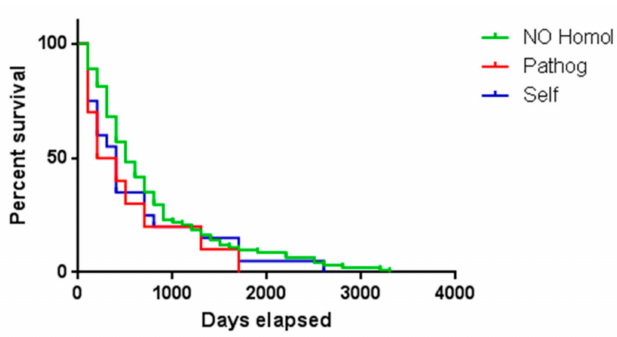
Figure 8. Similar to published epitopes and survival. Survival of HCC patients with neoantigens showing homology either to self or pathogen-derived epitopes from iedb.org or to any known